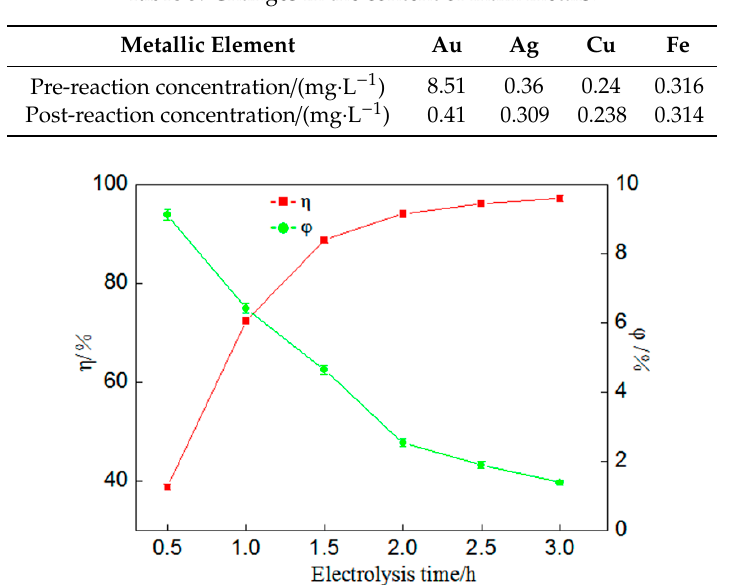
Table 5. Changes in the content of main metals.